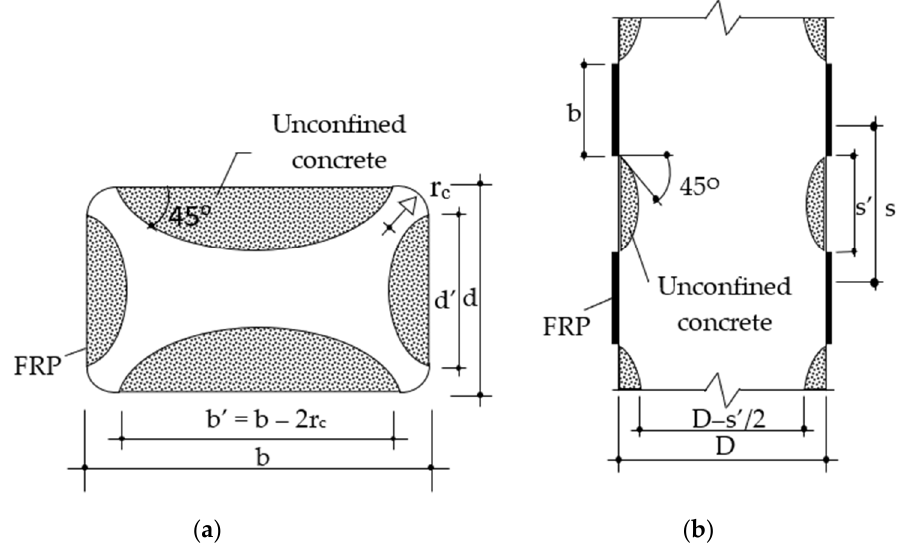
Figure 19. Effective confined area for columns with: ( a ) Rectangular section and ( b ) Partial FRP wrap. The axial load carrying capacity of uniaxial-bending columns, N Rd , can be calculated from Equation (18) derived in accordance with Euro Code 2